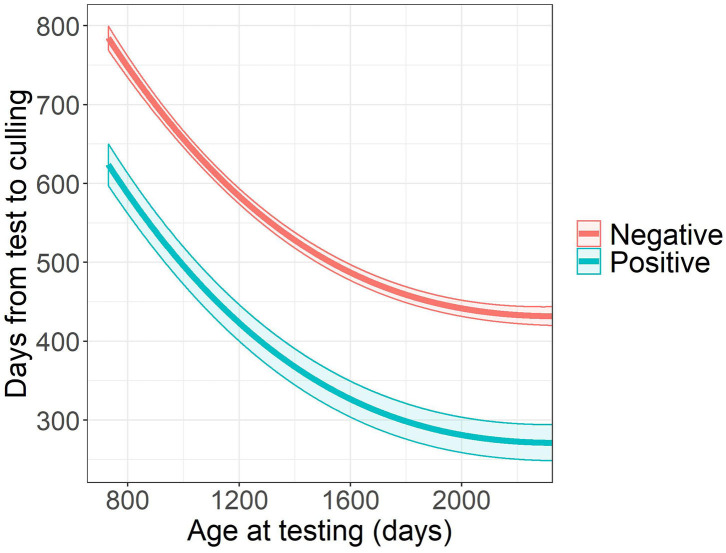
Estimated survival time after testing and its 95% confidence band by Mycobacterium avium subsp. paratuberculosis ELISA test resulta. aThe graph illustrates the survival time in herd A.